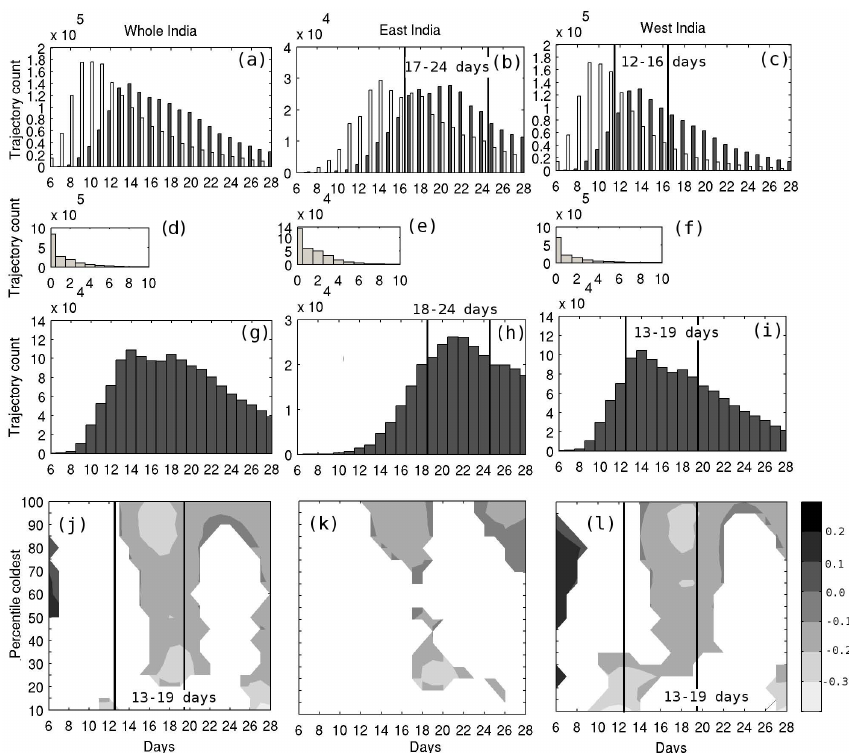
Fig. 3. (a–i) Trajectory times of air parcels for both West and East India domains (a, d, g) , East India (b, e, h) , West India (c, f, i) . (a–c) Light bars show trajectory times from the domain to the evaporative region; dark bars show trajectory times from the domain to interior Australia. (d–f) Time spent by air parcels in Australia before leaving the continent. Parcels at the zero bin have not left Australia by the 30th day. (g–i) Trajectory times from the domain to when the air parcels leave Australia. (j–l) sections of Fig. 4 matched to the same time scale on the